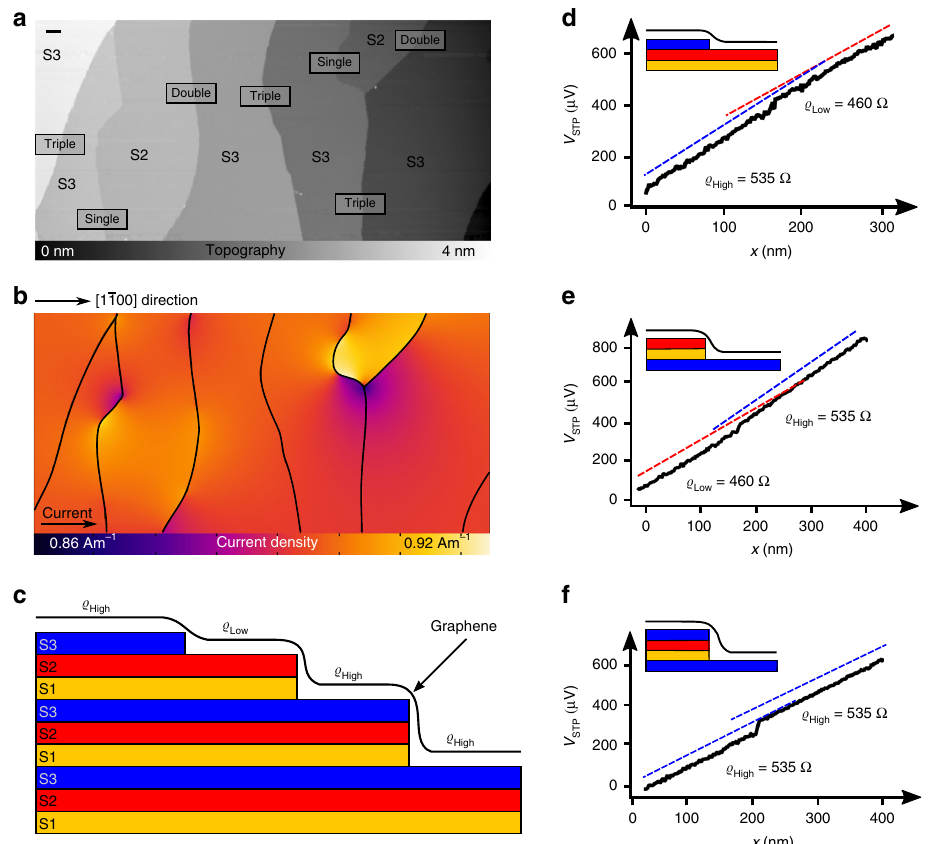
Fig. 1 Current density and evaluation of the local sheet resistance at room temperature. a Large-scale constant current topography (2 µ m × 1 µ m, V ¼ 0 : 5 V ; I ¼ 0 : 03 nA ). S1, S2, and S3 indicate the fundamental bilayers (and thus the stacking) of the SiC substrate, details are given in the Bias T discussion. STP measurements were performed in the marked areas (black boxes). The height of the steps is denoted in the marked areas, the scale bar is 100 nm. b Using the macroscopic ohmic resistance, the sample geometry shown in a and step resistances of 6 Ωμ m, 12 Ωμ m, 18 Ωμ m for single, double, x ; y ð Þ is calculated with a fi nite element simulation. c Schematic side and triple steps, respectively, the ½ 1 (cid:1) 100 (cid:2) component of the local current density j local view of the crystal structure of 6H-SiC. d Measured voltage drop along the graphene layer induced by the cross voltage V cross when crossing a single step. Dashed lines represent the slope of the voltage drop (shifted for clarity). e Corresponding measurement for a double step and f for a triple